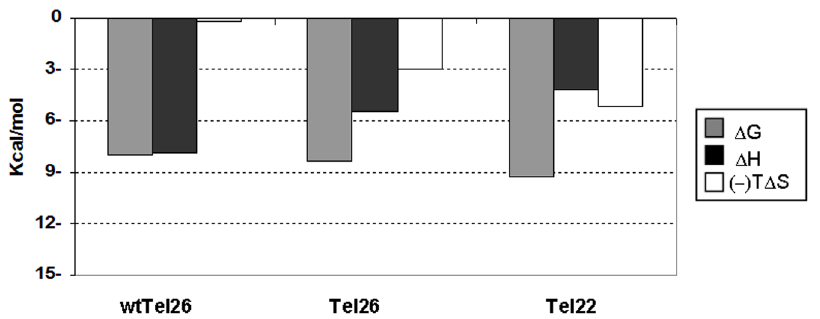
Figure 3. The energetic contribution for (K34) 2 Ni(II) binding towards tested G-quadruplexes is differently modulated. Energetic contributions describing the interaction between tested G-quadruplexes and (K34) 2 Ni(II) at 37 u C in 10 mM Tris, 20 mM KCl, pH 7.5. The associated enthalpic variations ( D H) are shown in black, the entropic ones (-T D S) in white and the Gibbs energy changes ( D G) in grey.